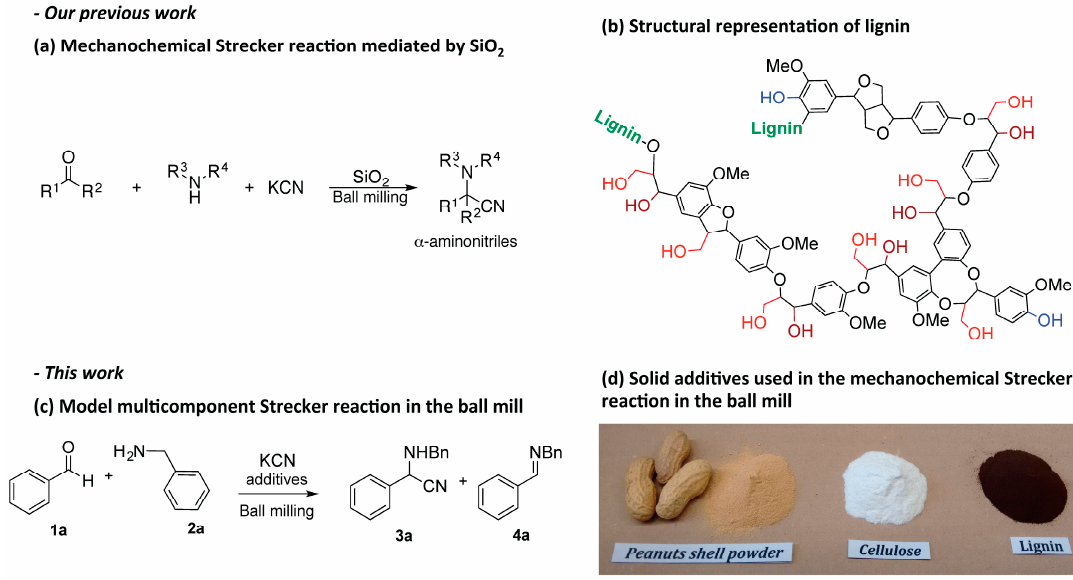
Figure 1. ( a ) Mechanosynthesis of α -aminonitriles mediated by SiO 2 ; ( b ) Structure of lignin; ( c ) General mechanochemical Strecker reaction; ( d ) Natural heterogeneous additives tested as activators for the mechanochemical Strecker reaction.